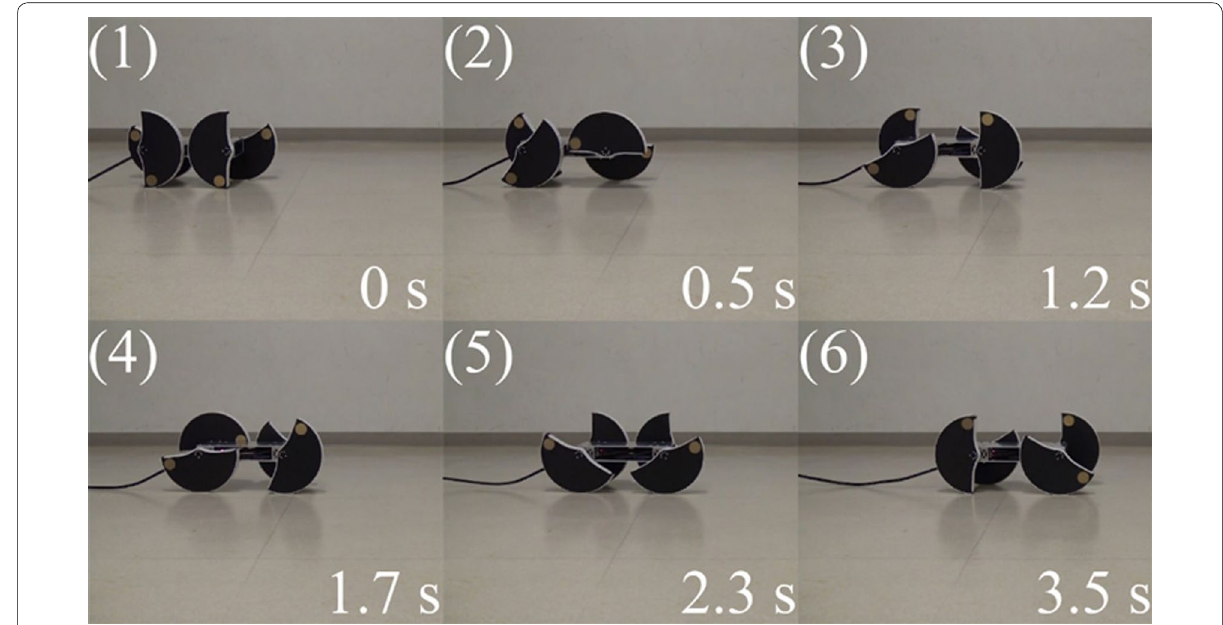
Pivot turn is possible when the right and the left wheels have the same angular velocity and reverse direction as the blue and the yellow line in Fig. 16. The basic phase change is the same as the crawl gait, but only one side wheel rotates in the reverse direction. Phase changes in the order of (1), (2), (3), (4) in Fig. 18. The phases of the wheels of the blue arrow are shifted by 30 degrees from each other, and the wheels of the red arrow rotate at three times the speed of the blue arrow.